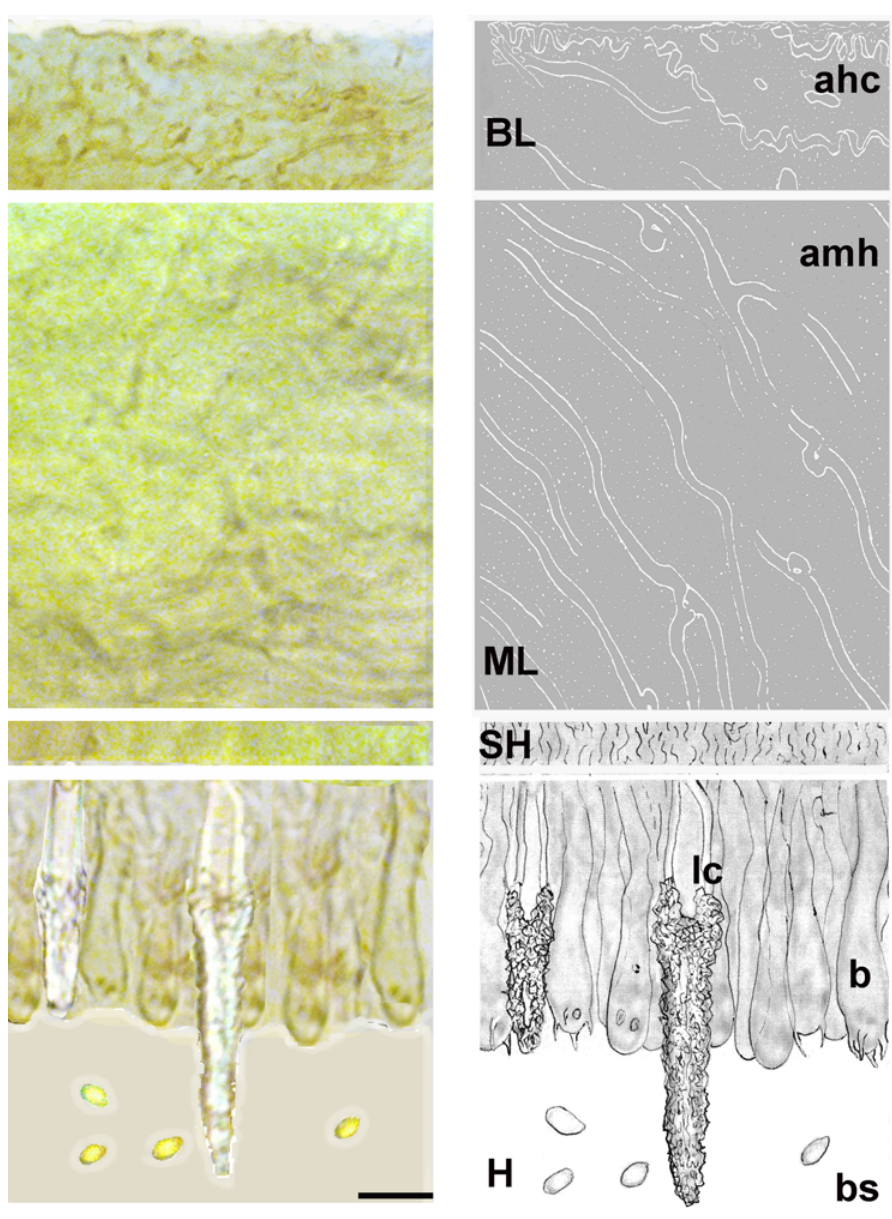
Fig. 2. Transverse section through basidiocarp of Phlebia tremelloidea : BL – basal layer with coiled agglutinated hyphae (ahc – agglutinated hyphae of cuticular cover); ML – agglutinated medullar hyphae (amh) producing a mucilaginous secret (gray phone) which forms cartilagi- nous matrix of basidiocarp; SH – subhymenium, composed by densely packed candelabriform hyphae; H – current hymenium with basidia (b), terminations of lamprocystidia (l) and basid- iospores (bs). Scale bar = 10 μm (fresh material; LE